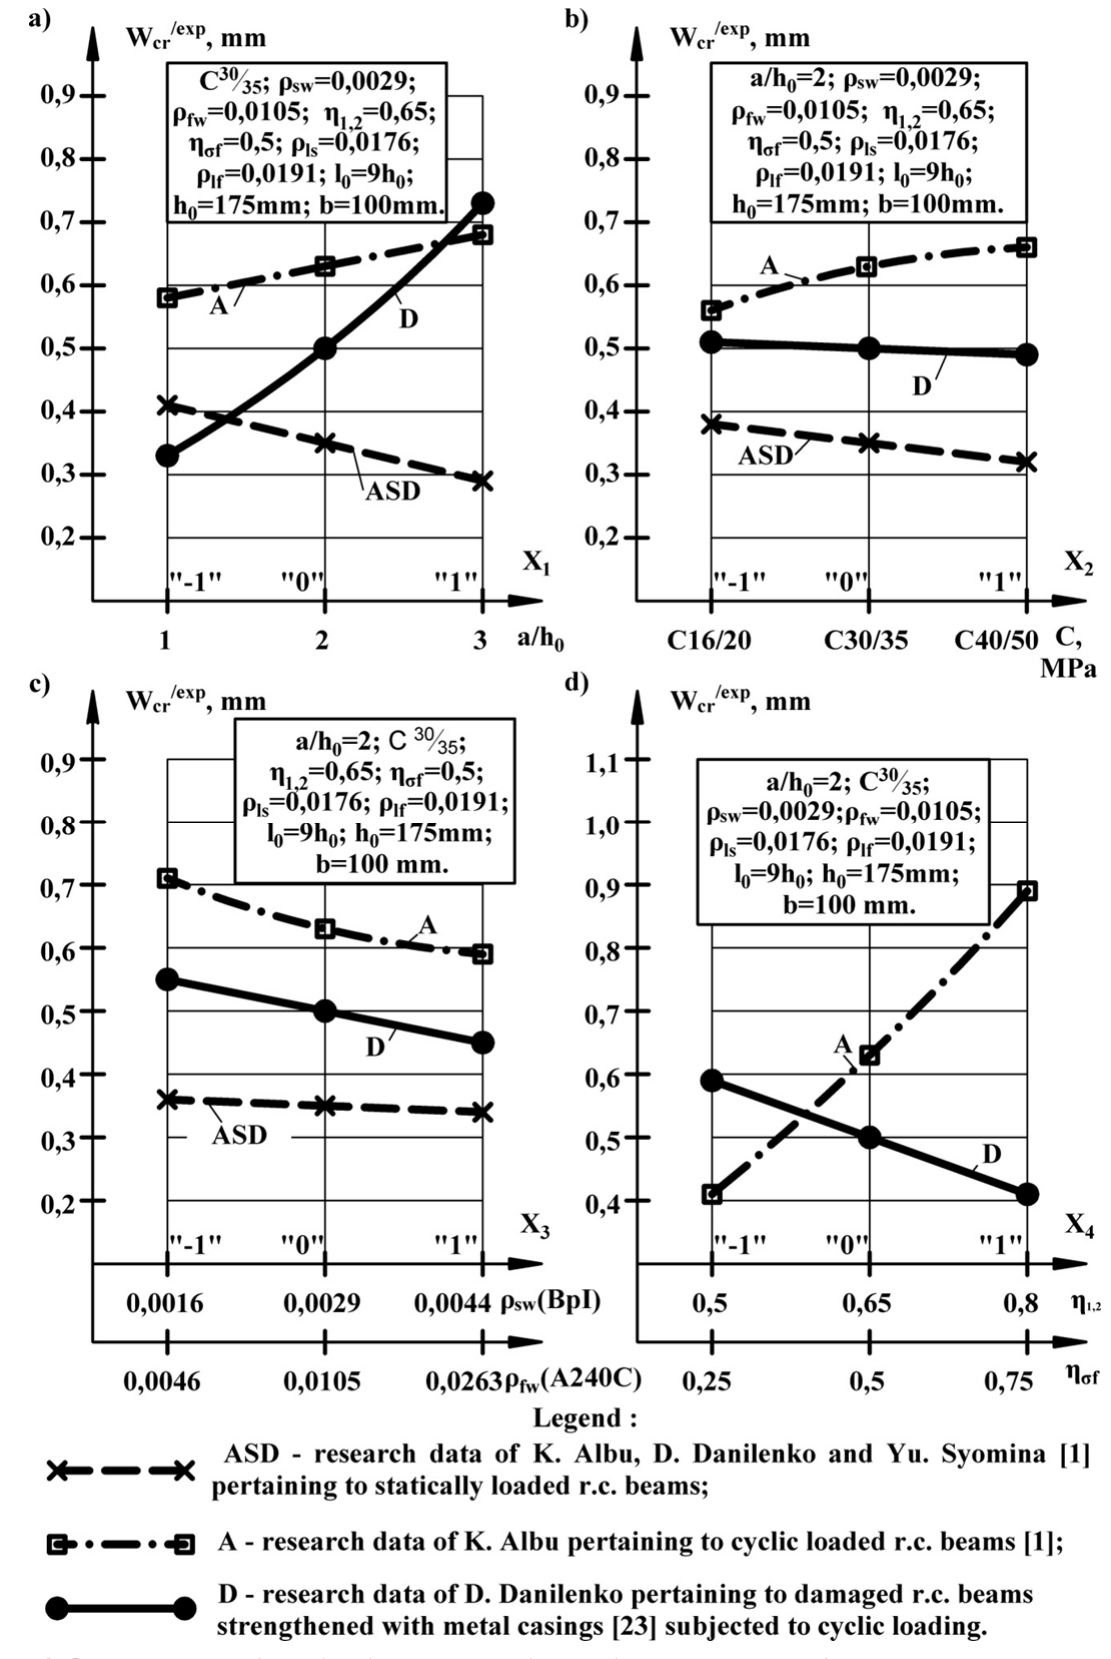
Figure 4. Dependence of the inclined crack width prior to collapse of the test beams on the value of the relative shear span ( а ), concrete grade (b), quantity of the transverse reinforcement (c), levels of the transverse loading and prestress of the metal casing elements